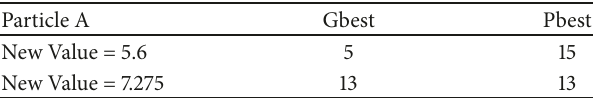
Table 2: The updated value of Particle A. Particle A Gbest Pbest New Value = 5.6 5 15 New Value = 7.275 13